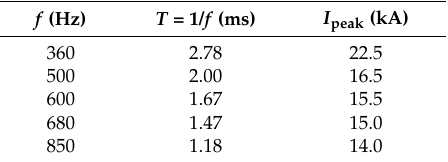
Table 3. Limit interruption current value for different frequencies.